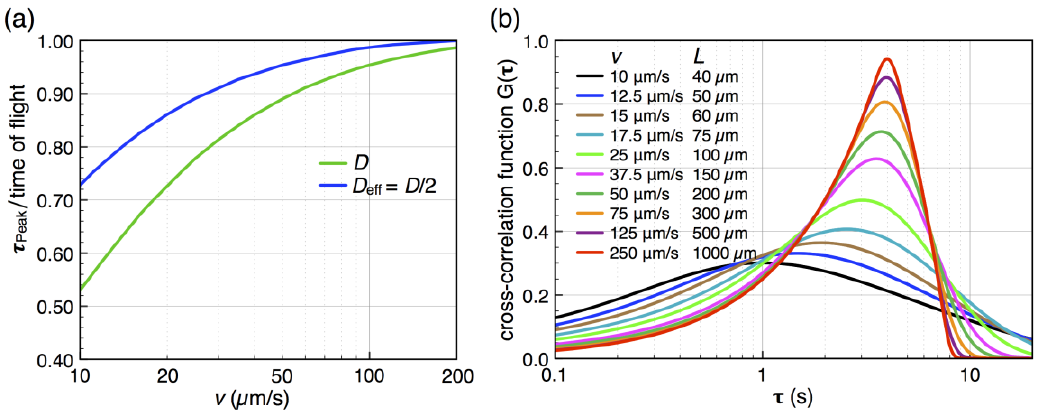
Figure 5. ( a ) Analytically determined deviation of the cross-correlation function’s peak time from the time of flight as a function of flow velocity. The blue curve is corrected for an effectively slower diffusion of the molecules due to dynamic adsorption. Experimental flow rates range from 15 μm/s to 50 μm/s. ( b ) Cross-correlation functions for a constant time of flight of 4 s but with different molecular velocities v (and corresponding different electrode lengths L or flight paths,